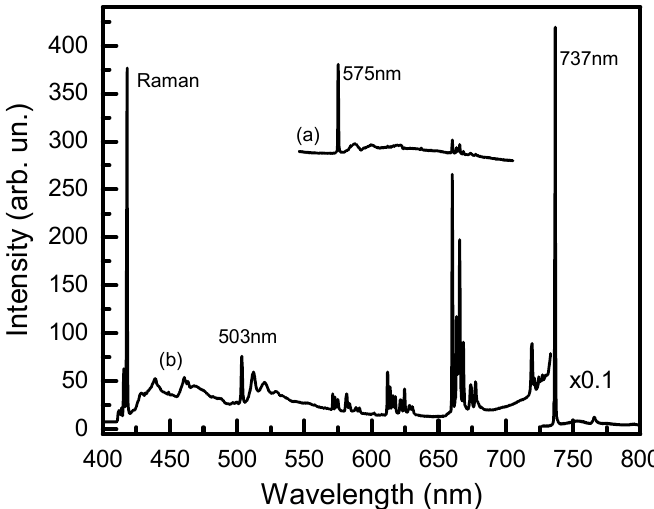
Figure 6. Photoluminescence (PL) spectra of diamond crystals synthesized with ( a ) 10 wt % and ( b ) 20 wt % of Sm 2 O 3 additives. PL was excited with a 395 nm laser. Spectrum ( a ) is arbitrarily scaled to facilitate comparison. The near-infrared part of spectrum ( b ) is multiplied by a factor of 0.1. The spectra are displaced vertically for clarity.